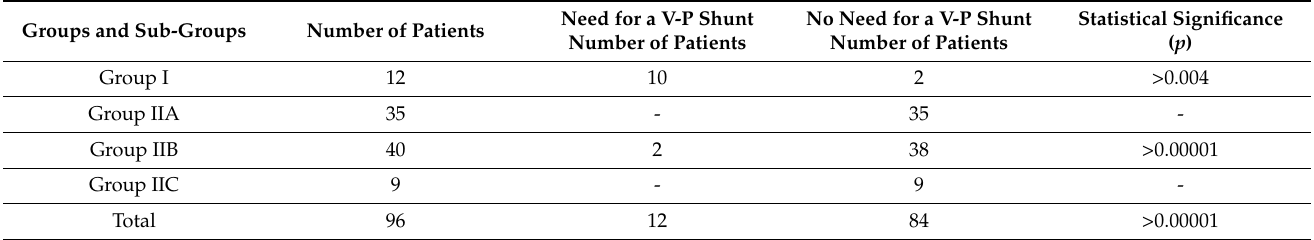
Table 2. The necessity of placing a V-P shunt in the study groups and sub-groups. Groups and